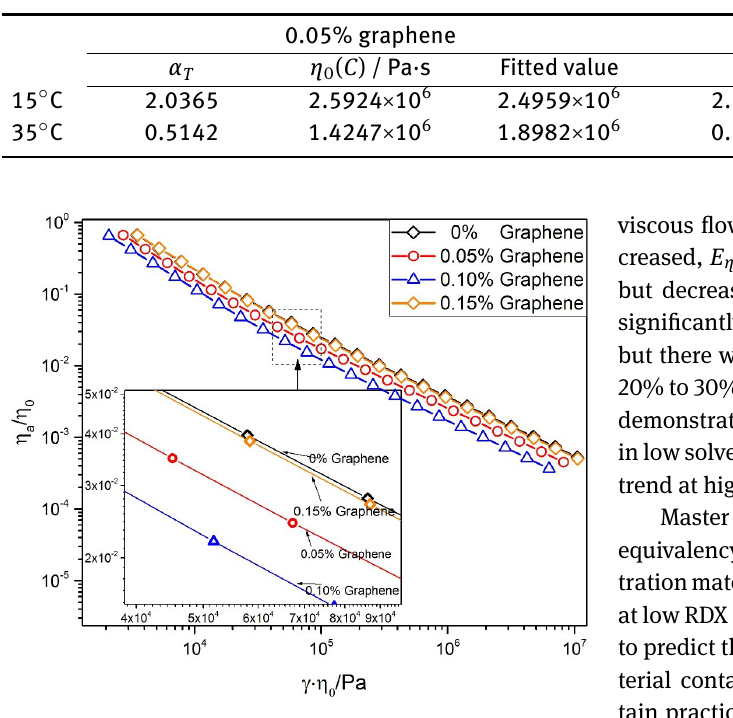
Table 13: Test value and calculated values of ZSV at different concentrations of graphene.